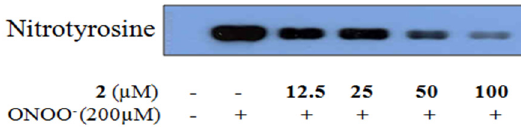
Figure 5. Effect of 2 on nitration of BSA by ONOO − . A mixture of the compound and BSA was incubated at 25 °C for 10 min. After incubation of ONOO − at 25 °C for 10 min, reactants were resolved by electrophoresis in a 10% SDS-polyacrylamide gel.